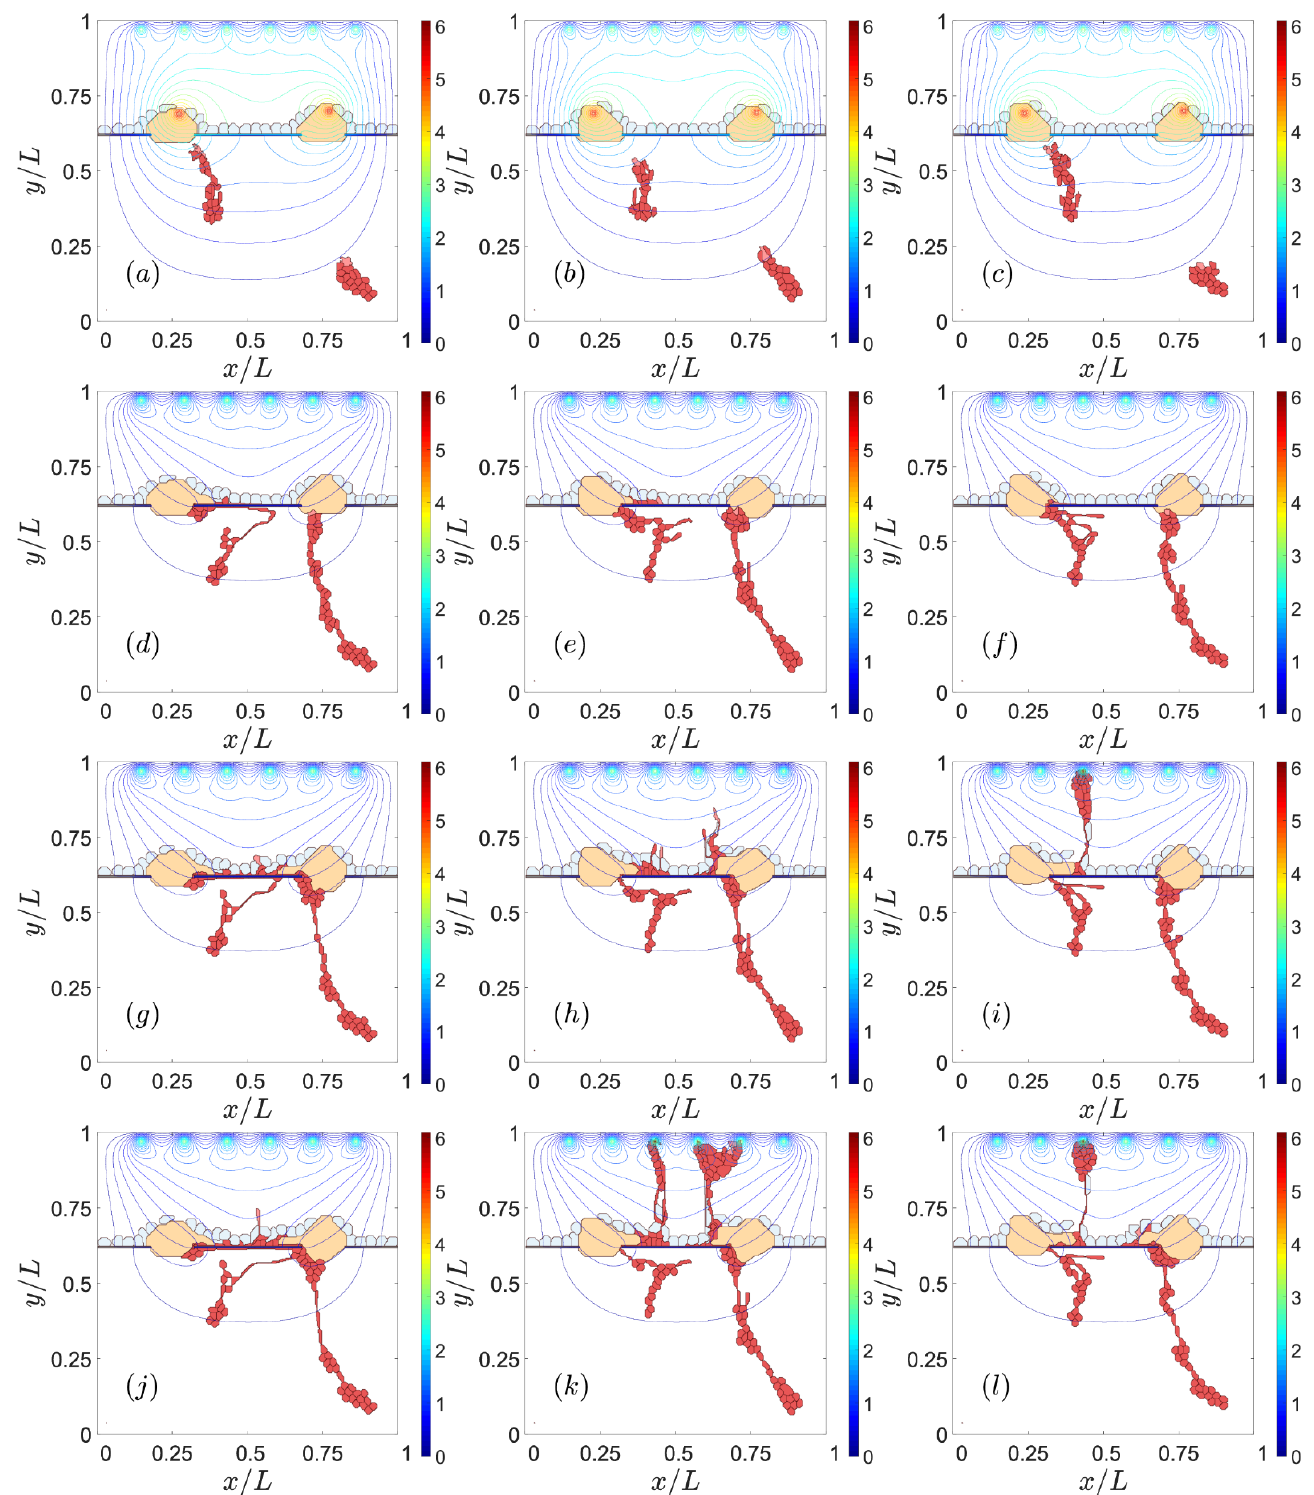
Figure 2. Effect of impaired adhesion between retinal pigmentation epithelium (RPE) and Bruch’s membrane (BM). Type 1 choroidal neovascularization (CNV) for ρ Step (MCTS), ( d ) 1601 MCTS, ( g ) 4501 MCTS, ( j ) 9001 MCTS. Type 2 CNV for ρ times: ( b ) 601 MCTS, ( e ) 1601 MCTS, ( h ) 4501 MCTS, ( k ) 9001. MCTS. Type 2 CNV for ρ at times: ( c ) 601 MCTS, ( f ) 1601 MCTS, ( i ) 4501 MCTS, ( l ) 9001 MCTS. We have represented the level curves of external VEGF as continuous lines.